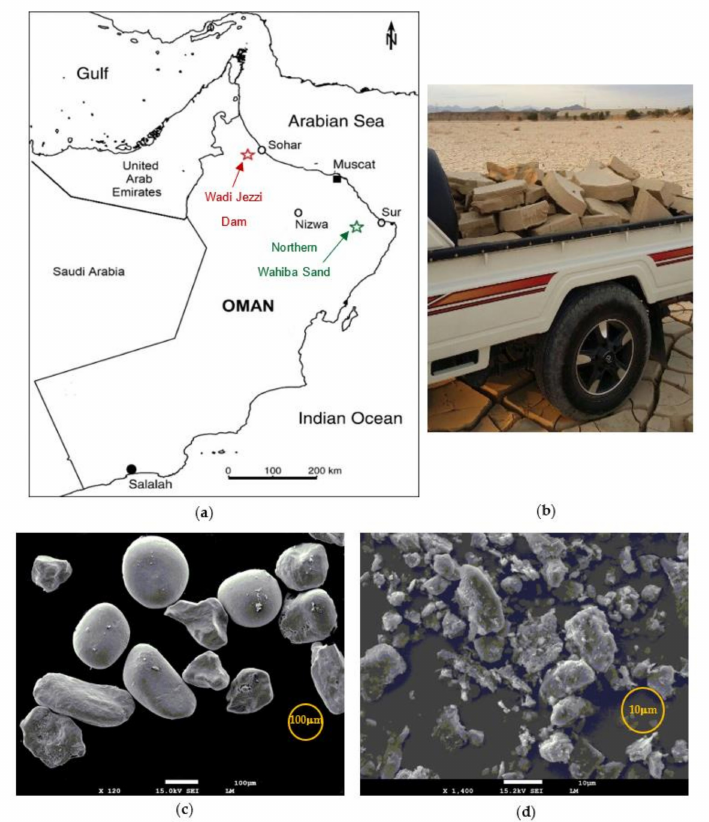
Figure 1. ( a ) Location of Wadi Jezzi dam and Northern Wahiba Sands sampling sites, ( b ) example sampled reservoir sediments, and example photomicrograph of ( c ) dune sand (DS) and ( d ) reservoir sediments (RS). Note the different magnification between images ( c , d